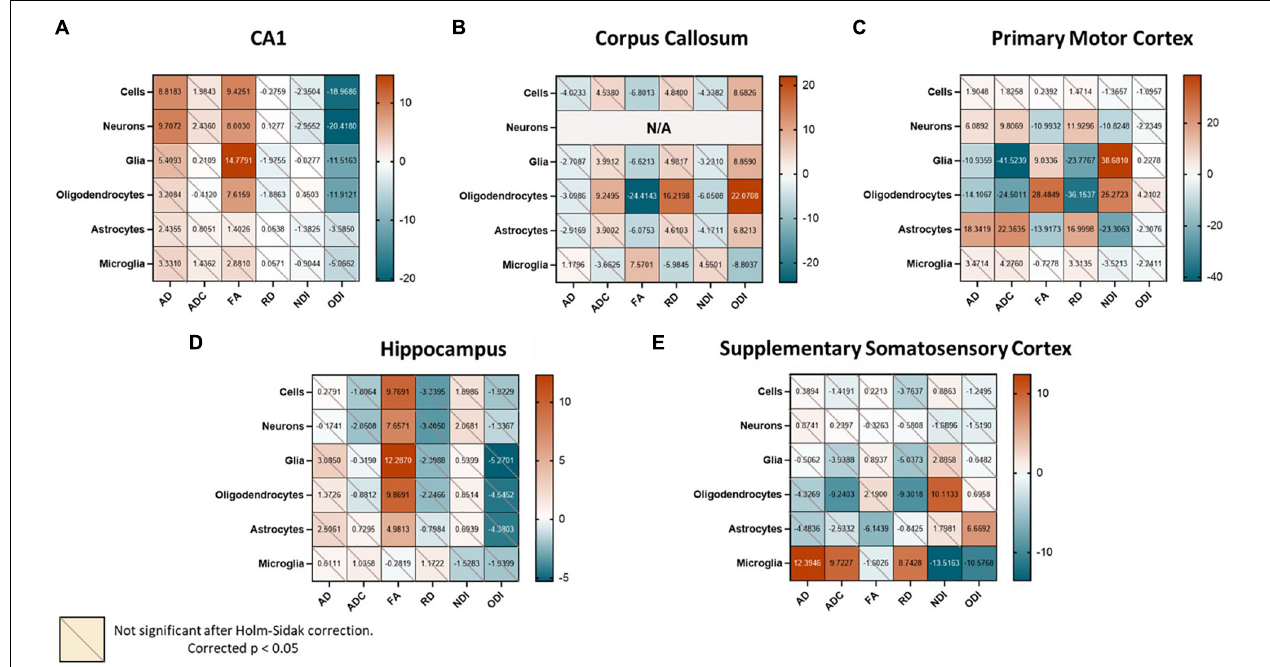
FIGURE 4 | When examining different regions, we find unique region-specific relationships between diffusion metrics and cell types. Values in the correlation matrix represent the t -value from a one-sample t -test of the Z-score of the Pearson correlation coefficient of each subject’s pair. “Cells” represent counts of all cell types studied, and “Glia” is the sum of oligodendrocyte, astrocyte and microglia counts. Subplots represent correlation matrices of individual regions: (A) CA1, (B) Corpus Callosum, (C) Primary Motor Cortex, (D) Hippocampus, (E) Supplementary Somatosensory Cortex.